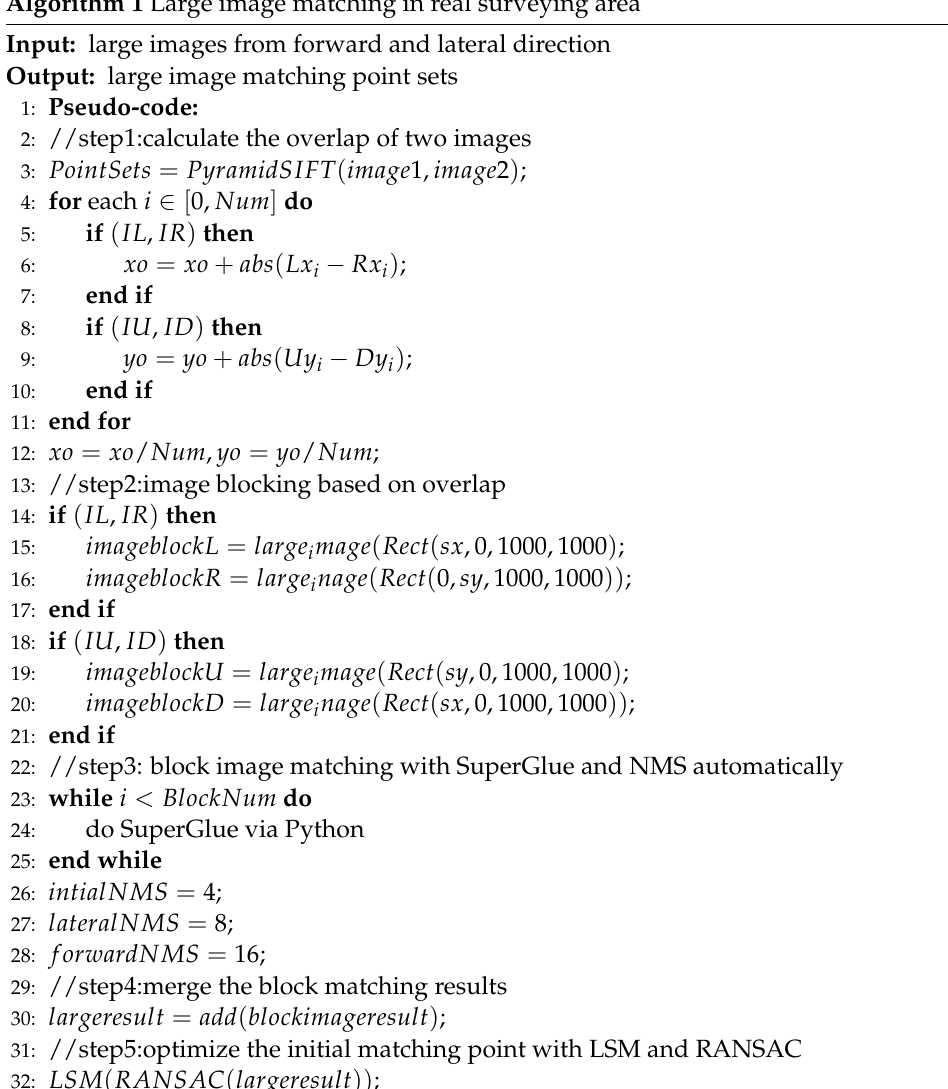
Algorithm 1 Large image matching in real surveying